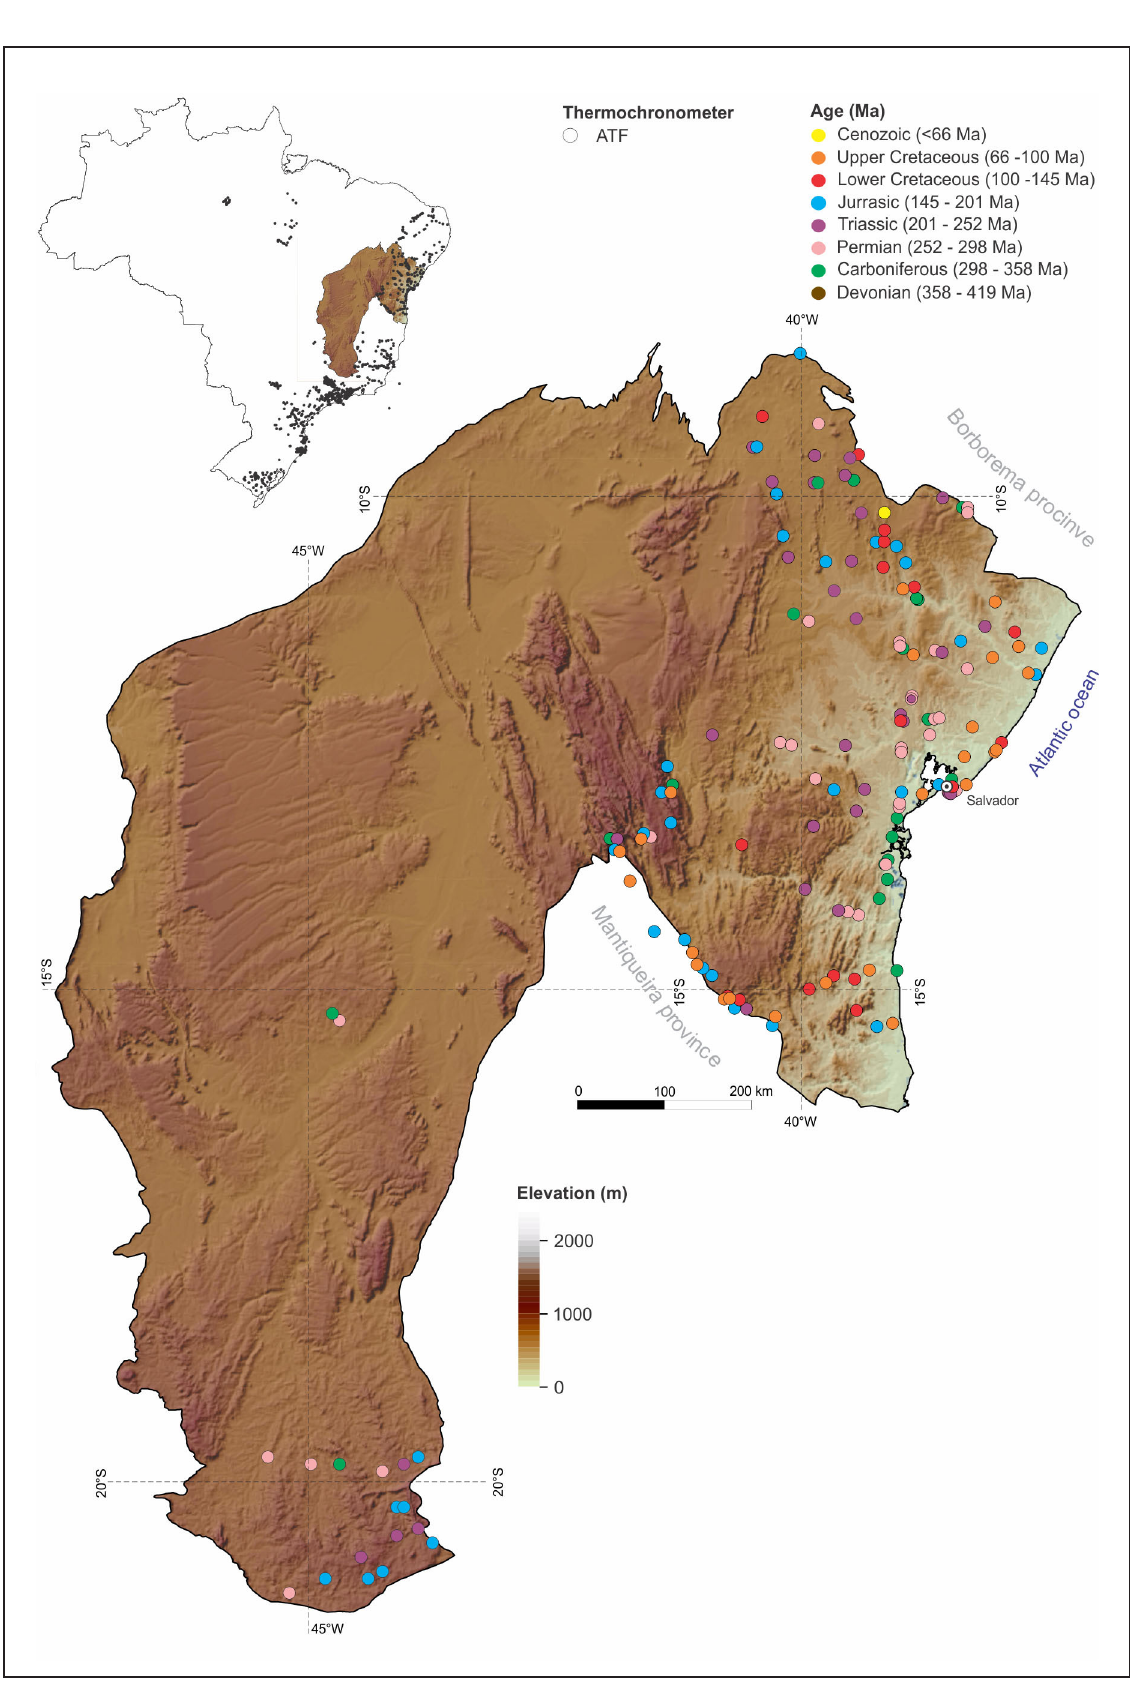
FIGURE 3 . Thermochronological data set published in the São Francisco craton. The detailed map highlights the northeast portion of the craton where thermochronological data are